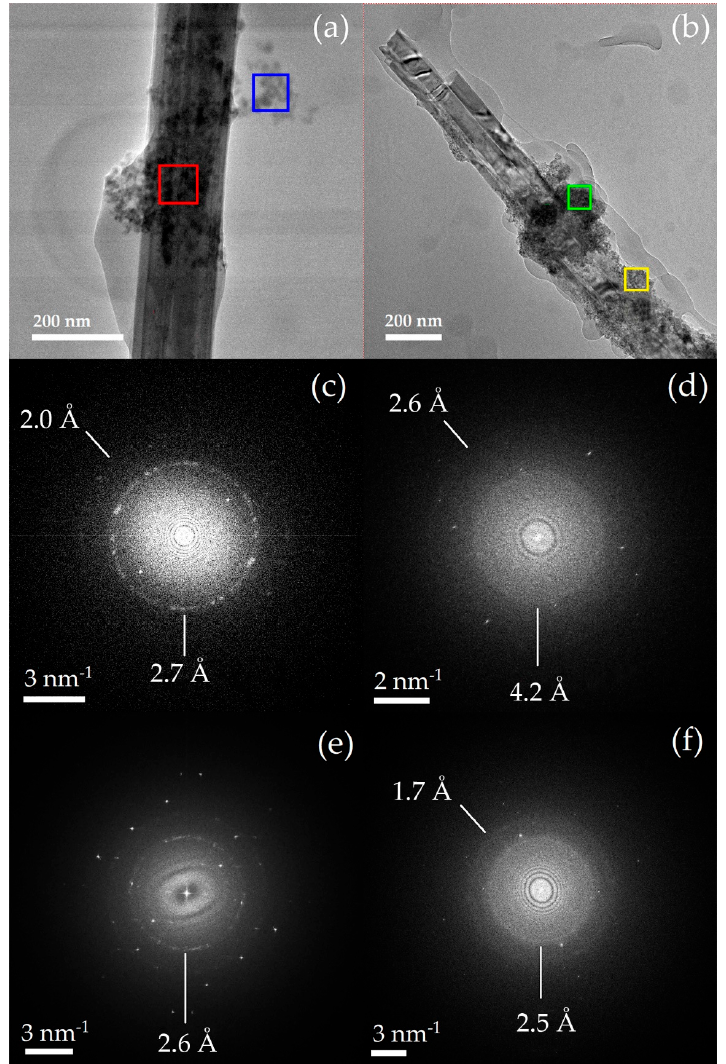
Figure 11. ( a , b ) TEM micrographs showing ABs on a crocidolite fibre; ( c ) FFT pattern extracted from HRTEM image of an AB shown in 11a (blue square is the region of interest); ( d ) FFT pattern extracted from HRTEM image of an AB shown in 11b (green square is the region of interest); ( e ) FFT pattern extracted from HRTEM image shown in 11a (red square is the region of interest); ( f ) FFT pattern extracted from HRTEM image of an AB shown in 11b (yellow square is the region of interest). Diffraction rings at 2.6, 2.0 and 1.7 Å may be attributed to ferrihydrite. Diffraction rings at 2.7 Å may be attributed to apatite. Diffraction rings at 4.2 and 2.5 Å may be attributed to goethite.